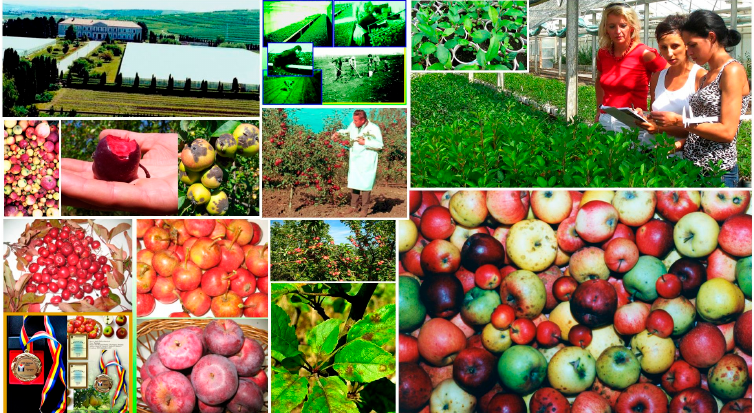
Figure 5. Fruit tree breeding history and activity at HRS Cluj-Napoca: induction of genetic variabil- ity (especially through artificial hybridization, selection, and development of new cultivars) and education and training of young specialized scientists.